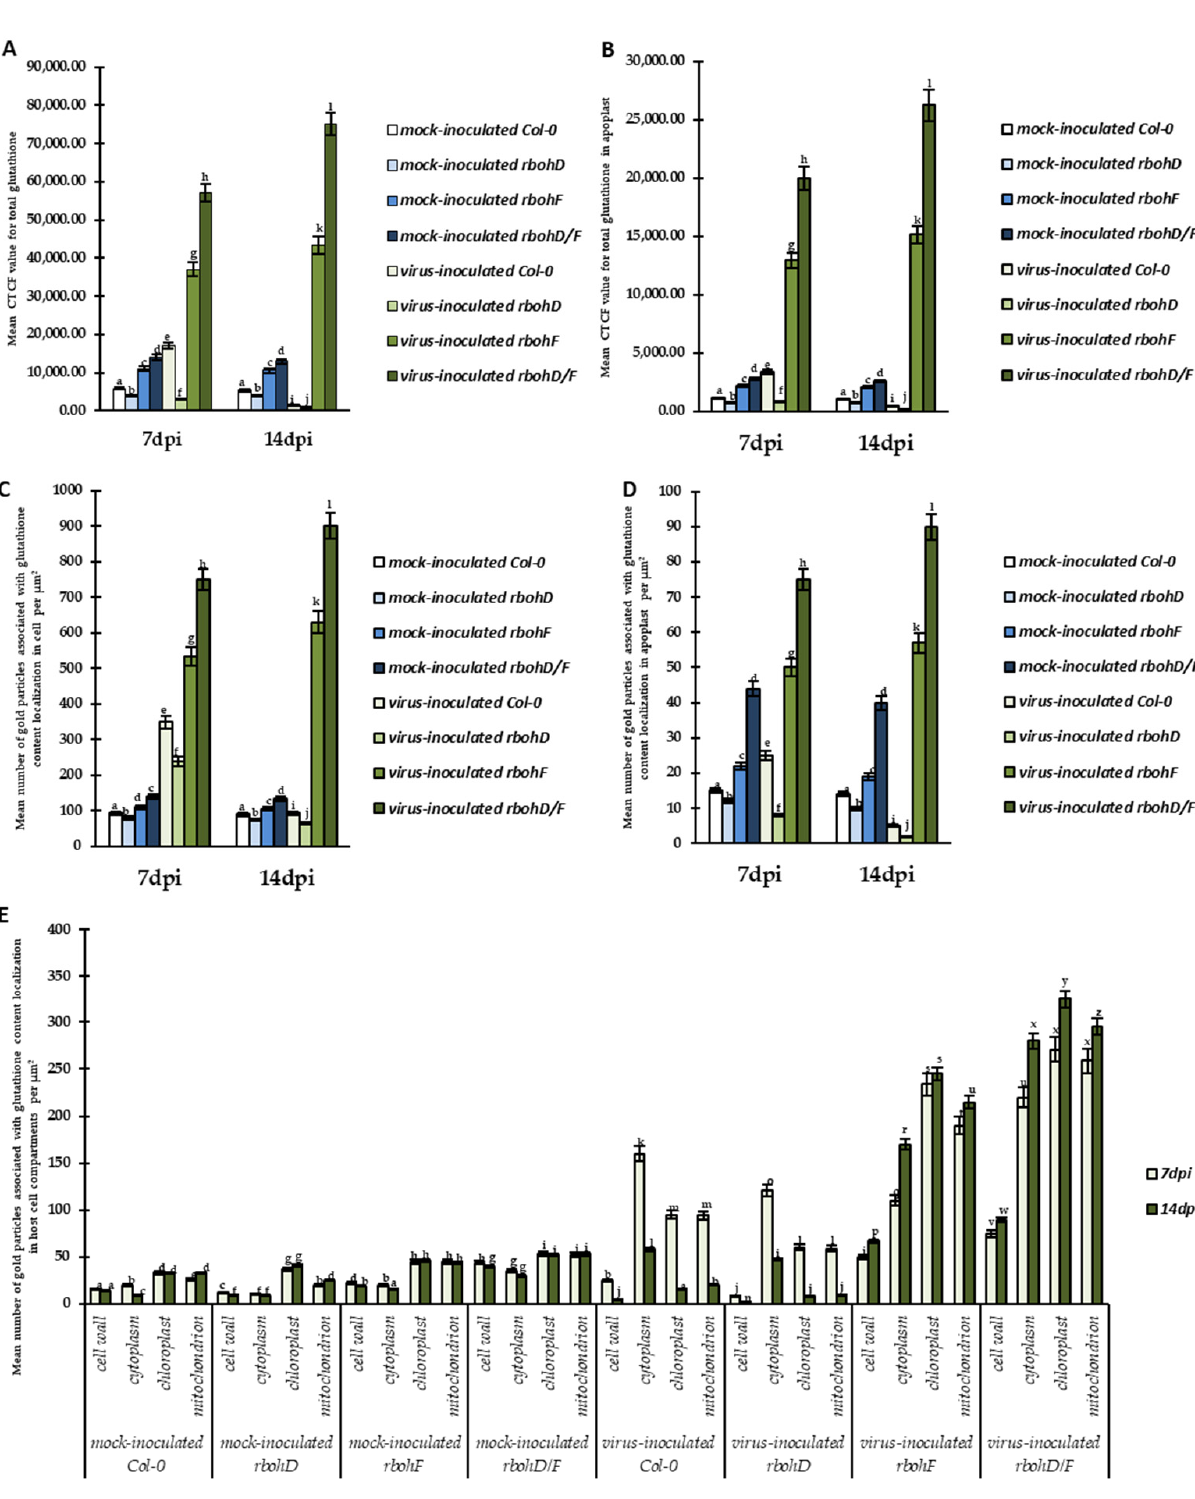
Figure 4. Quantification of total glutathione with the use of: fluorescence signals based on cell total corrected fluorescence and quantified immunogold labeling in the cell ( A , C ), apoplast ( B , D ) and cell compartments ( E ) in TuMV- and mock-inoculated Col-0, rbohD , rbohF , and rbohD/F plants between 7 and 14 dpi. Using ANOVA and Tukey’s HSD test, the mean fluorescence/mean number of gold particles µ m 2 of GSH and GSSG was calculated at p < 0.05. Statistically significant values are indicated by different letters above the bars.